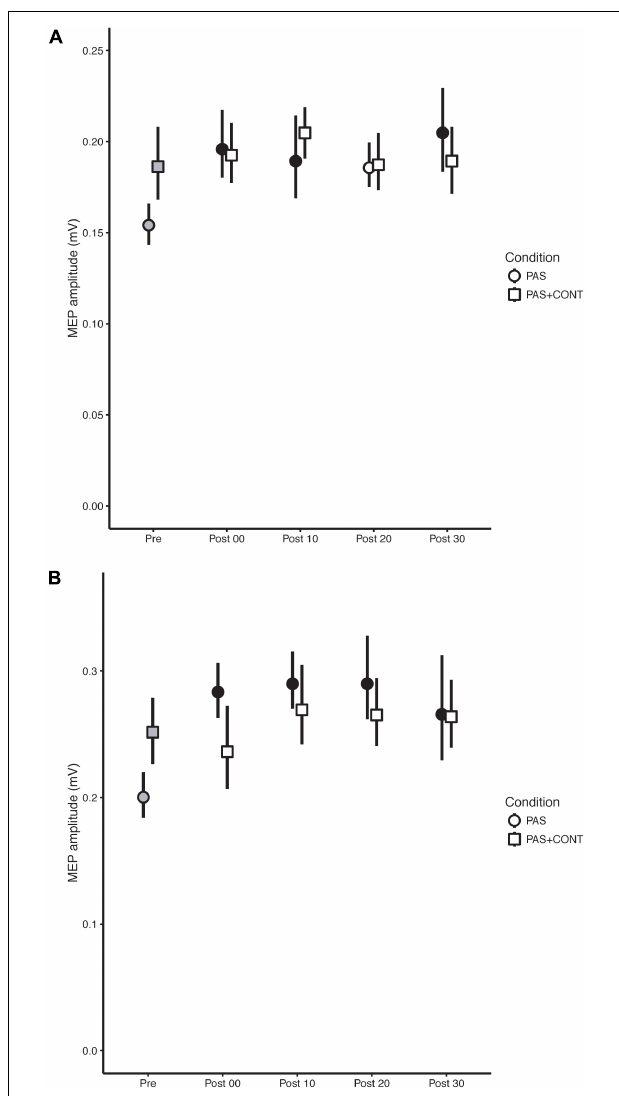
FIGURE 2 | Stroke survivors. The mean ( n = 10) MEP amplitude values obtained for the flexor carpi radialis (FCR) muscle (A) and extensor carpi radialis (ECR) muscle (B) at each time of measurement (Pre, Post00, Post10, Post20, and Post30), are shown for the respective experimental conditions: paired associative stimulation (PAS); PAS plus contraction (PAS + CONT). The error bars are the 95% “Cousineau-Morey” confidence intervals. The values recorded prior to the intervention are shown as filled gray symbols. Instances in which a post-intervention measurement differed reliably from the pre-intervention value are shown as filled black symbols.